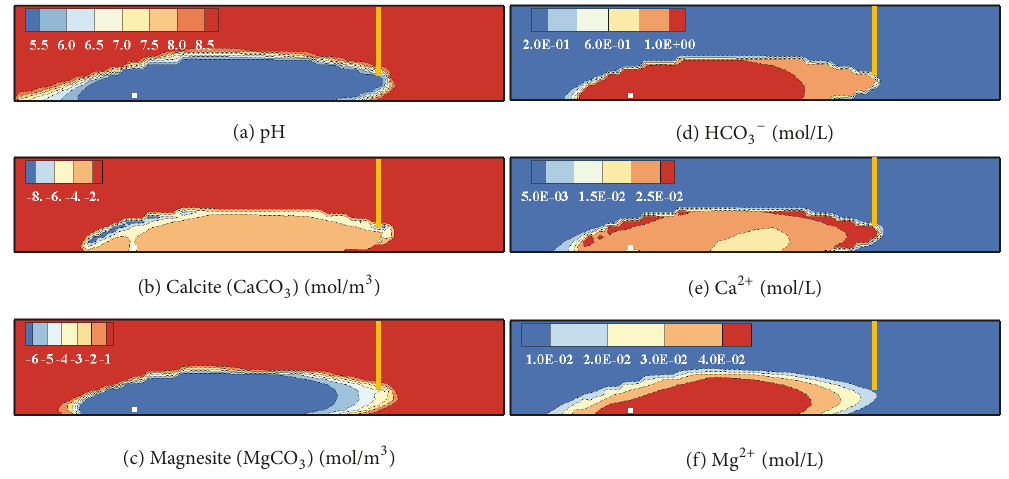
Figure 5: Distribution of pH, carbonate minerals (calcite and magnesite), and associated dissolved species (HCO 3− , Ca 2+ , and Mg 2+ ) after 365 days.